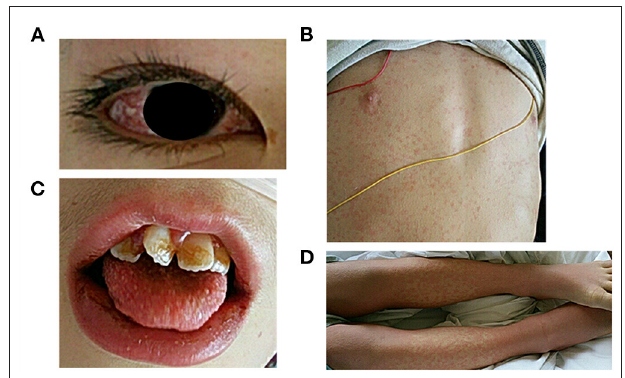
FIGURE 1 | Visual examination performed at the time of admission to our hospital. (A) conjunctival injection, (B) skin rash, (C) erythema of the lips and strawberry tongue, (D) erythema and edema of the